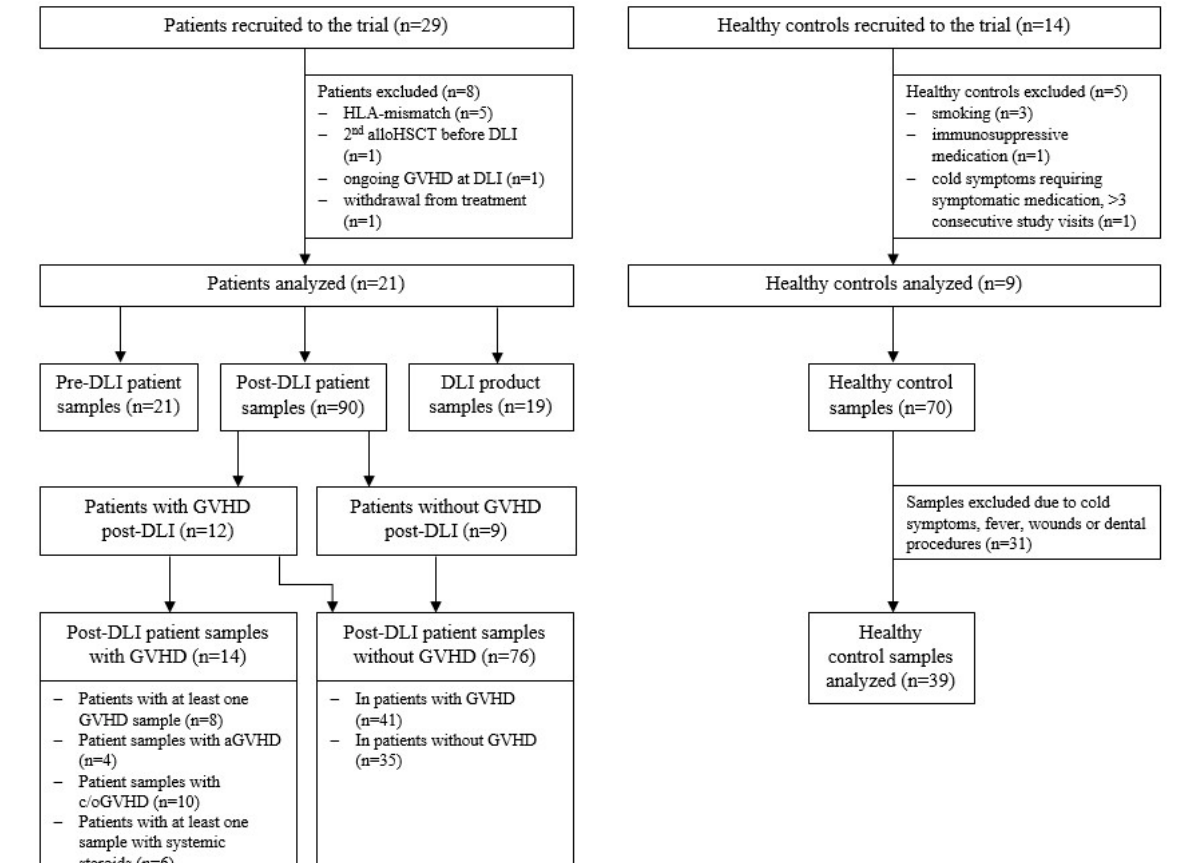
Figure 1. Details of study recruitment and numbers of samples. Abbreviations: HLA, human leukocyte antigen; alloHSCT, hematopoietic stem-cell transplantation; aGVHD, acute graft-versus-host disease; c/oGVHD, chronic/overlap graft-versus-host disease; DLI, donor lymphocyte infusion. 2.2. Patients without GVHD Exhibited a Healthy-LIKE CD4 + CD25 + CD127 low T reg and CD4